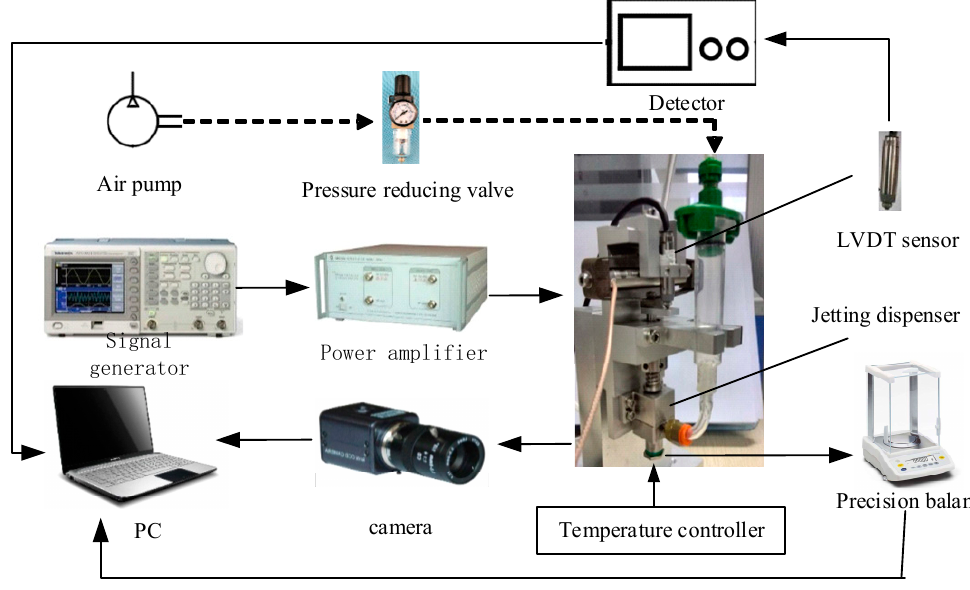
Figure 2. The schematic of the experimental platform.